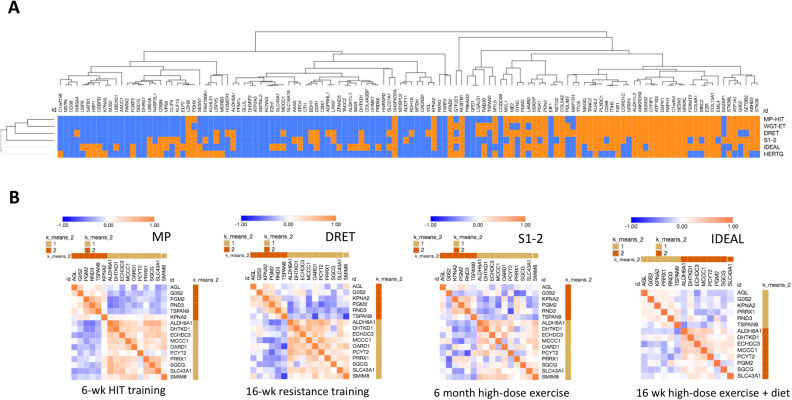
Treatment-responsive insulin-sensitivity genes. Supervised exercise-training (with or without calorie restriction) can improve peripheral IS (48,50) and is considered the primary tool to reduce the risk of developing type 2 diabetes. If the Core-IS genes regulate IS they should respond to clinical interventions and do so in a manner consistent with the observed improvement in IS. (A) Differential gene-expression for 332 Core-IS genes was calculated, across six intervention studies (three were independent of the baseline IS analyses), P-values aggregated using the Stouffer method; and a false discovery rate (FDR) was calculated (60). Approximately 40% of genes were differentially regulated (FDR < 5%) by treatment, and critically in a direction consistent with their observed relationship with fasting IS, and despite the highly divergent nature of the exercise/life-style modification interventions. (B) The relationship between the magnitude and direction of CORE-IS gene expression and the magnitude and direction of IS responses to clinical intervention were calculated using Spearman rank correlation. Individual HOMA2-derived IS were not available for the HERTG (insulin assay) or the Weigert et al. (38) (data availability) studies. This lead to the identification of a subset of 16 genes, from ∼250, that were consistently correlated with change in IS, in all the four independent studies. The 16 genes segregated into two subsets—one (DHTKD1, SLC43A1, PCYT2, MCCC1, SGCG, ECHDC3, ALDH6A1, SMIM8 and OARD1) positively associated with improvements in IS, and one (PGM2, RND3, G0S2, AGL, TSPAN9 and KPNA2) negatively associated. Many CORE-IS genes, especially belonging to network 1 and 2 (Figure 5 and Table 3) were also, on average, DE following 3 months of a PPARγ agonist (Supplemental data S5, (56)) - unfortunately no individual IS values were accessible from the authors to study the quantitative correlative relationship with IS.